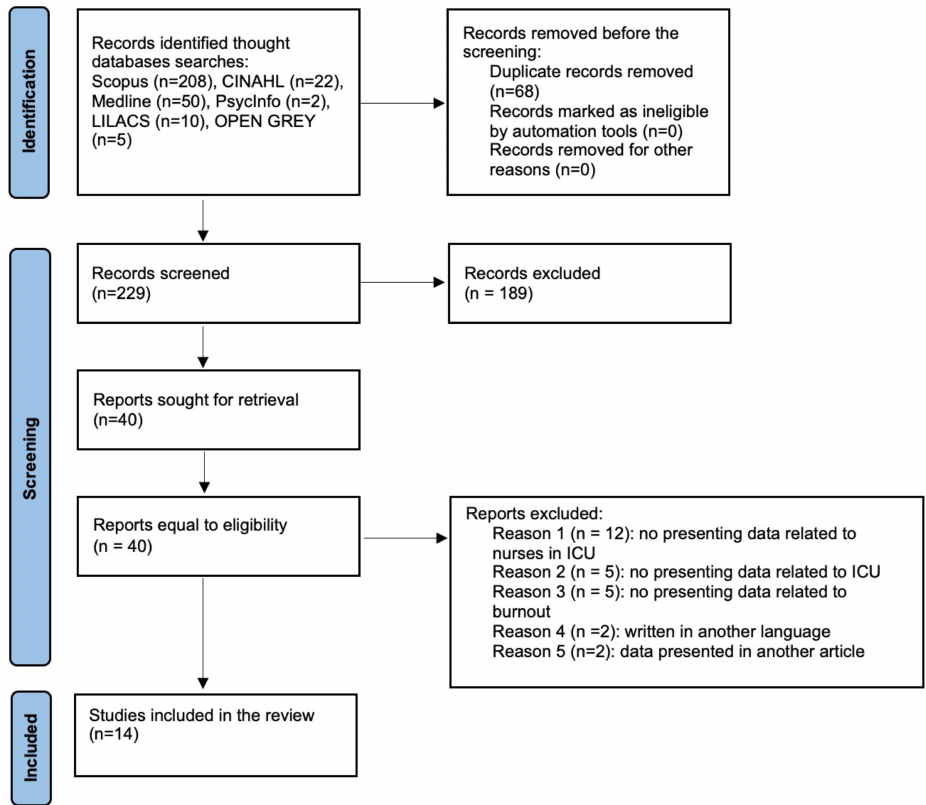
Figure 1. PRISMA flowchart of the study selection